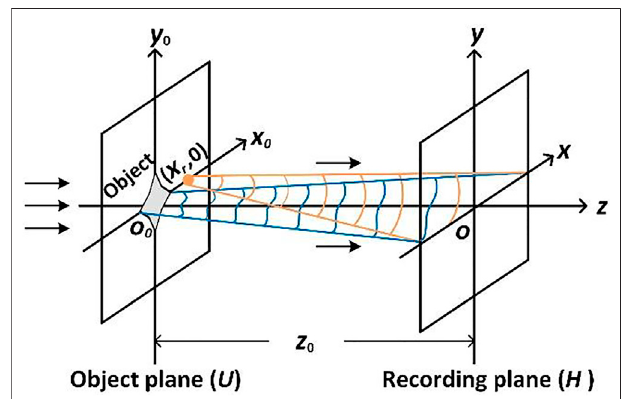
FIGURE 1 | Schematic of the coordinate system of object plane and recording plane of lensless Fourier-transform